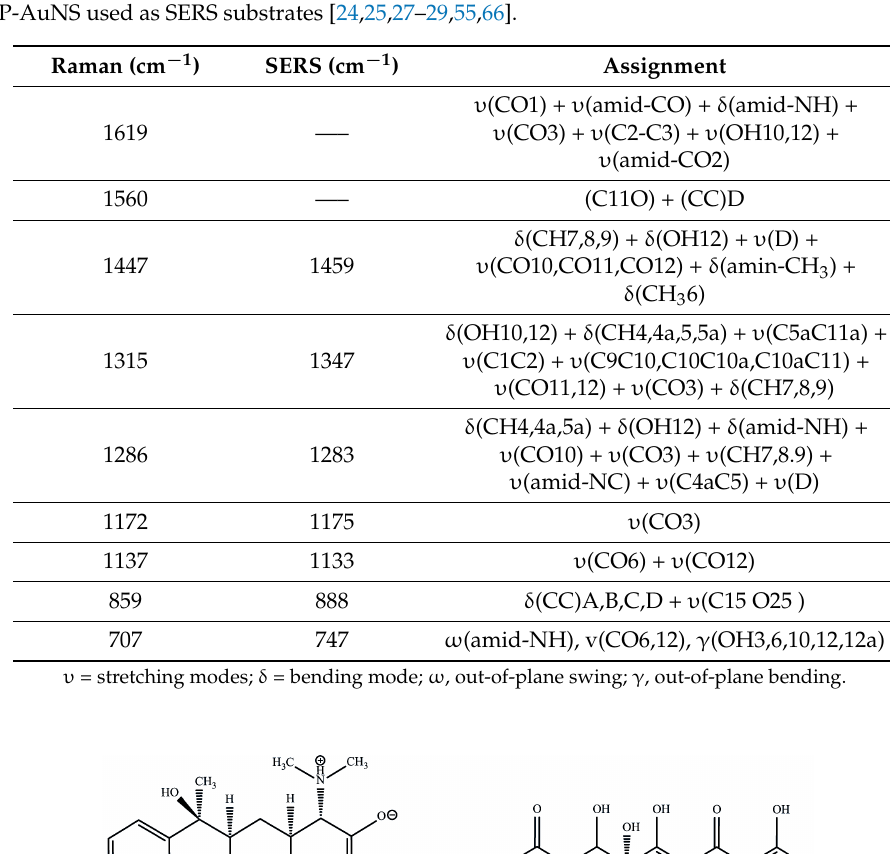
Table 1. Raman bands and respective assignments for the TC powder and TC adsorbed onto